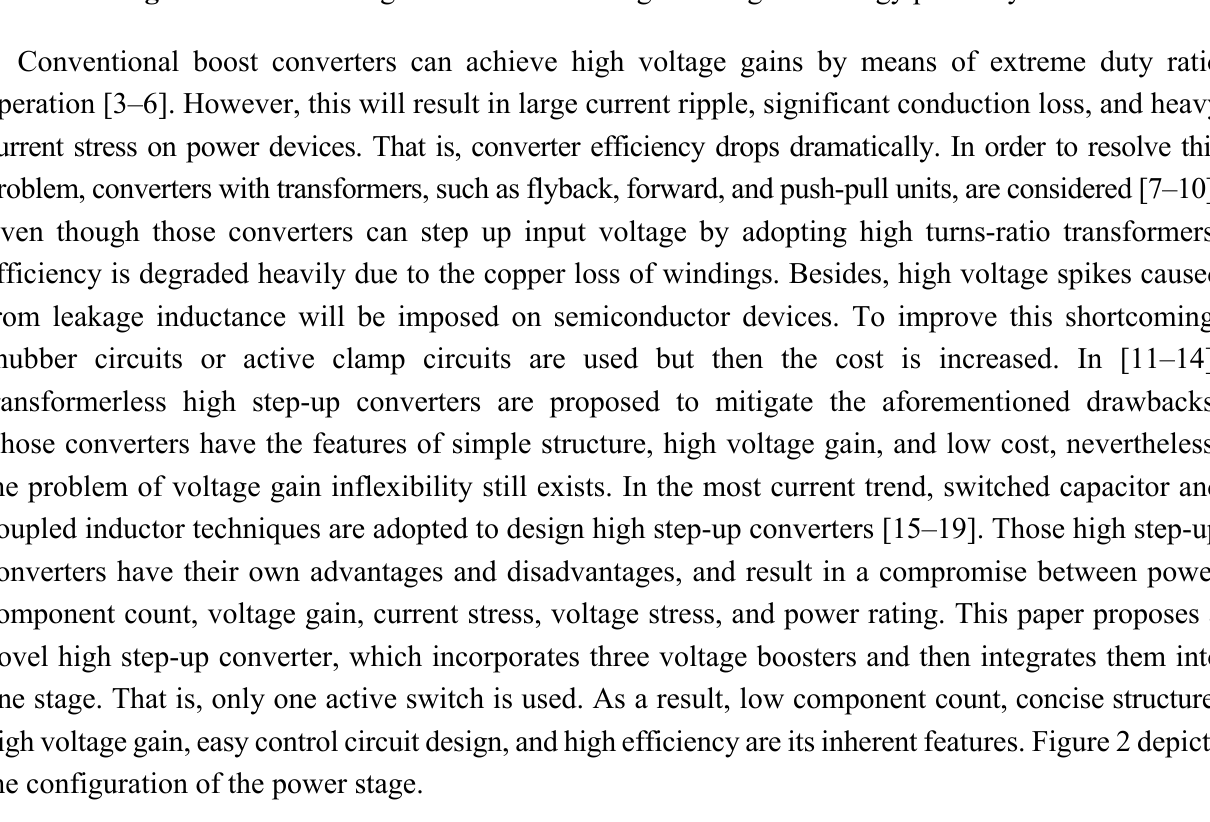
Figure 1. A block diagram to illustrate the grid-tied green-energy power